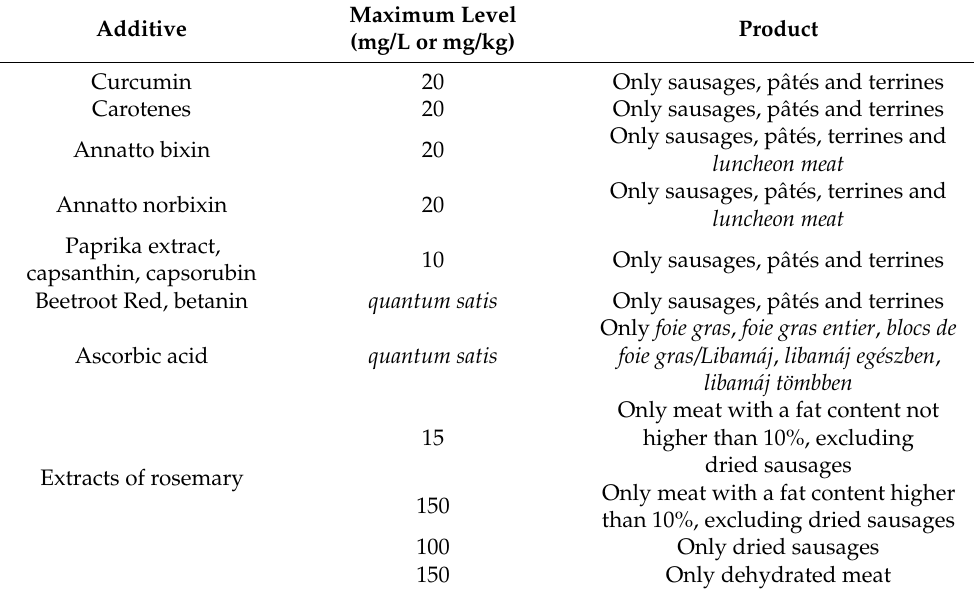
Table 2. Compounds/ingredients obtained from plants allowed for use as food additives in meat products by the EU that could confer antioxidant